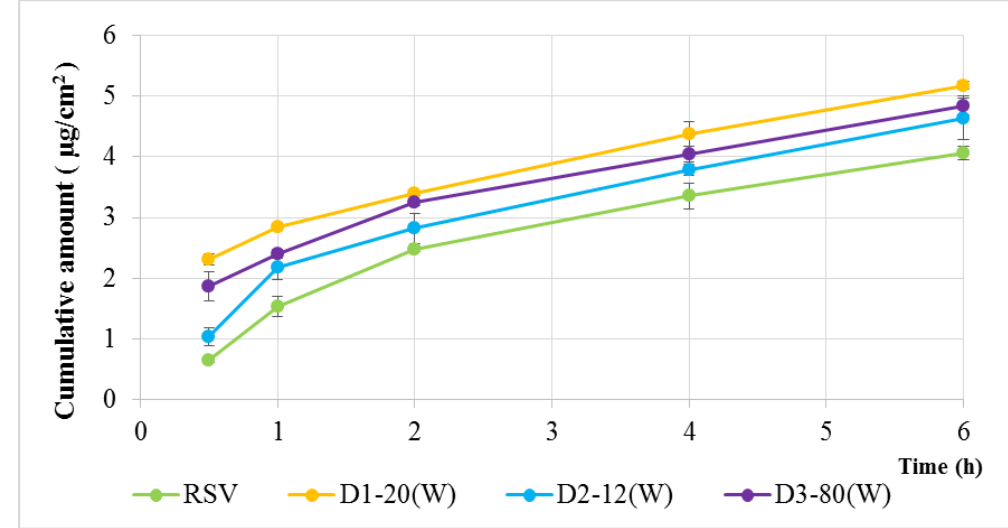
Figure 5. In vitro release profiles of RSV and RSV transfersomes (D1–20(W), D2–12(W), and D3–80(W) groups). The sample with 1.0 mL was placed in the donor site and 5.0 mL consisting of PBS and ethanol (70:30, v / v) was put into the receptor site. These sites were separated with a 0.785 cm 2 Strat-M ® Membrane. The cumulative amount of RSV was analyzed in each time points.